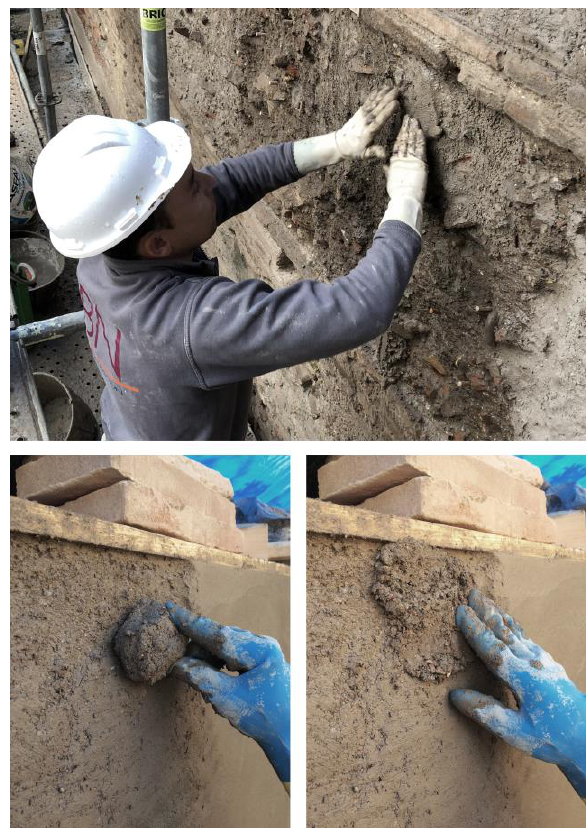
Figure 11. Surface reintegration with clay lumps, applied in the base and the final layer, by manual shaping and mashing.